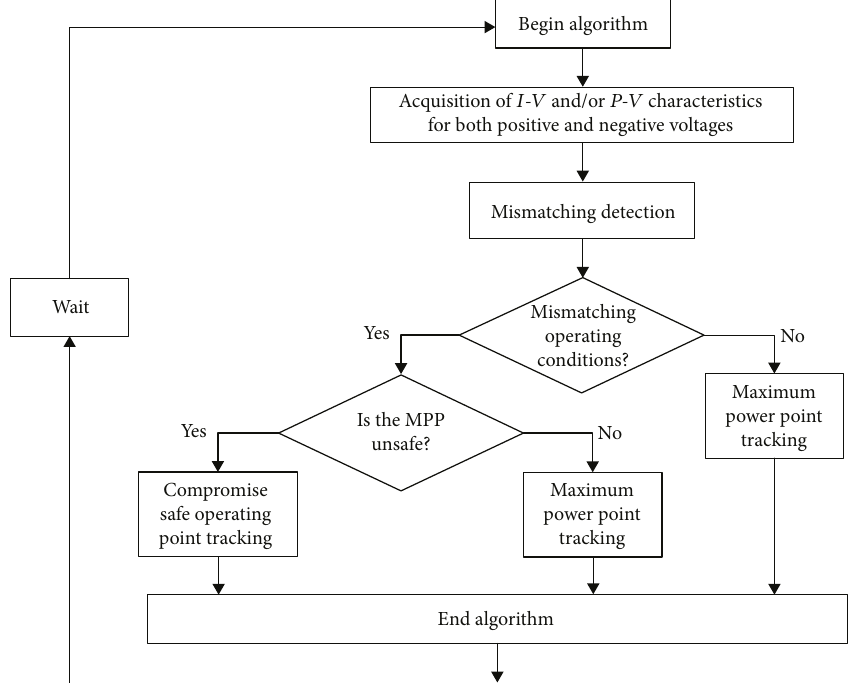
Figure 21: Flow chart example of an algorithm aimed at identifying a proper operating point allowing a suitable compromise between maximization of extracted power and minimization of thermal